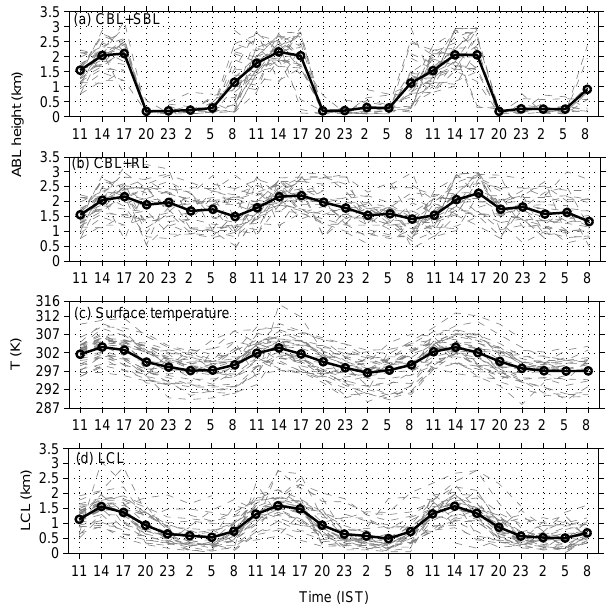
Figure 9. The 3-day diurnal variability of (a) the ABL (CBL + SBL) considering all the data observed for the CBL and SBL, (b) the CBL + RL considering all the data observed for the CBL and RL obtained using T variable, (c) the surface temperature, and (d) the LCL height observed during the period December 2010– March 2014.